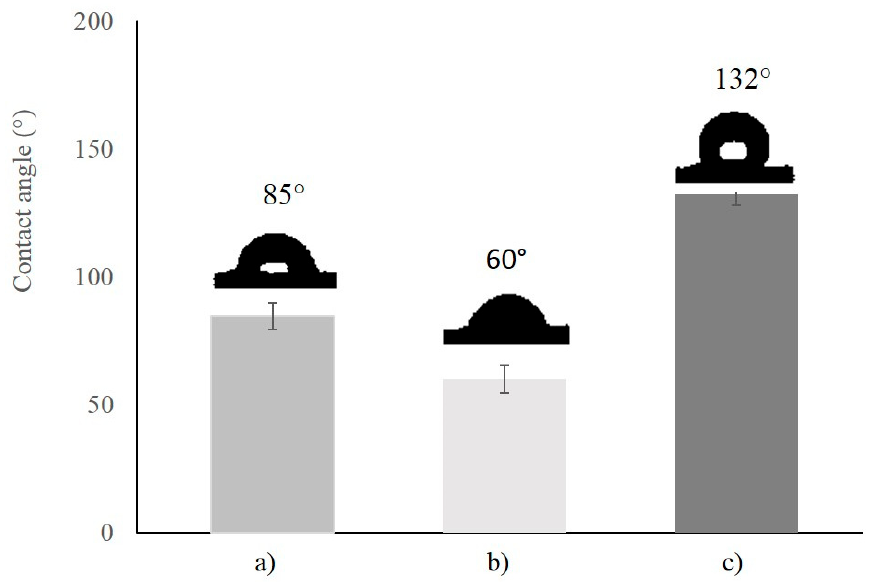
Figure 5. Water contact angles on the cotton surfaces: ( a ) untreated cotton, ( b ) plasma-treated cotton after grafting with acrylic acid and ( c ) treated cotton after immobilization of phosphorus monomer. The results shown are averages of three measurements and the error bar represents the standard deviation.